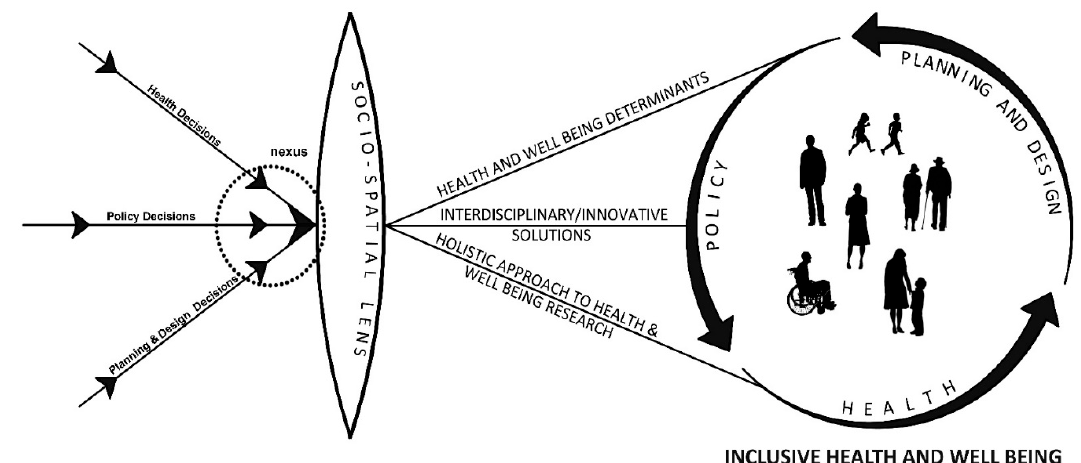
Figure 5. A socio-spatial framework for inclusive health and well-being. Source: Author.